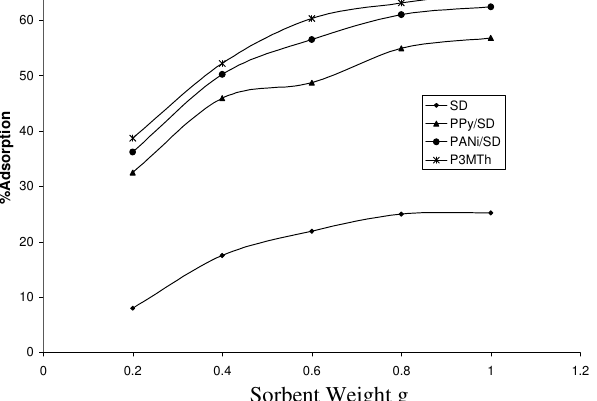
Figure 7. Effect of SD, PPy/SD, PANi/SD and P3MTh/SD dosage on the adsorption percentage of As(III). PH=11 and C